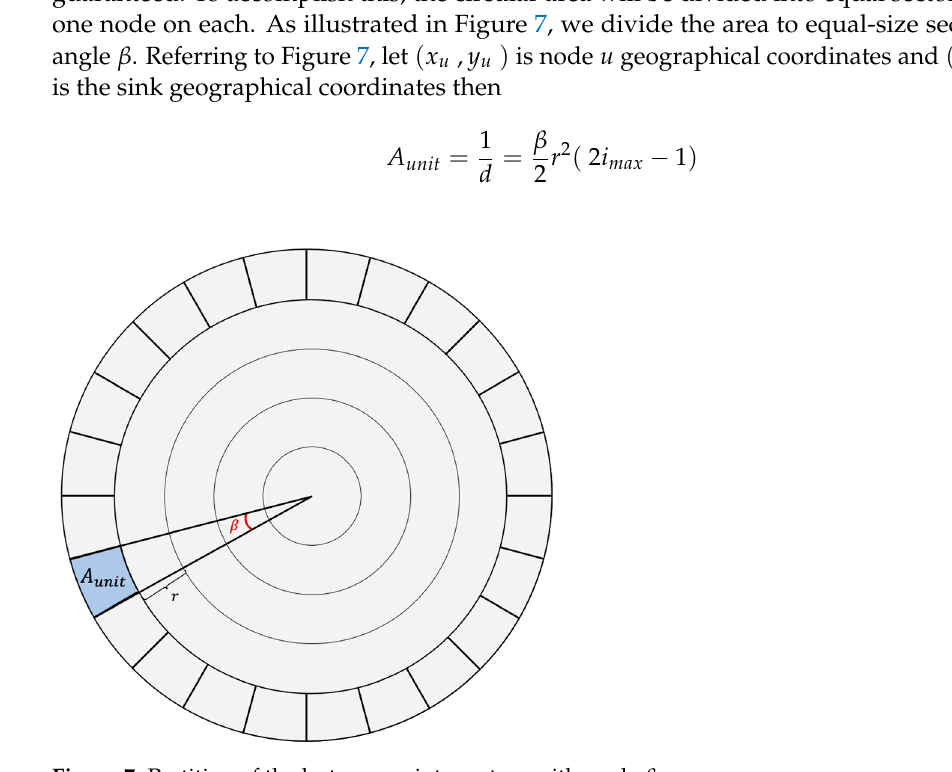
Figure 7. Partition of the last corona into sectors with angle 𝛽 .